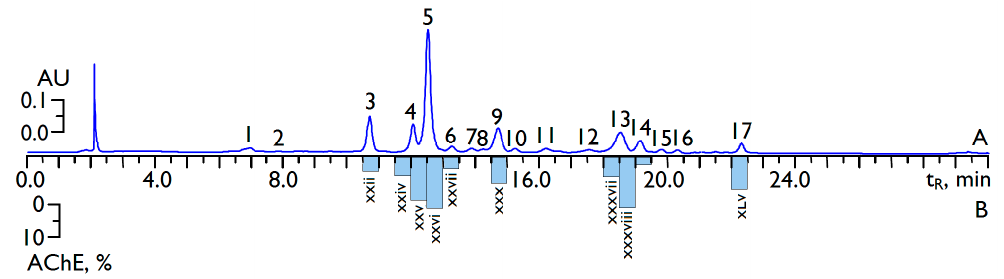
Figure 2. Chromatograms (microcolumn reversed-phase high-performance liquid chromatography with ultraviolet detection (MC-RP-HPLC-UV)) of 60% ethanol extract from C. officinalis of the Greenheart Orange variety at 350 nm (A) and HPLC-based anti-acetylcholinesterase activity (AChE) profiling (B). The bar graphs on B show the inhibitory activity of the individual HPLC fractions collected from a single separation. Compounds: 1, 3- O -caffeoylquinic acid; 2, caffeic acid; 3, manghaslin; 4, calendoflavobioside; 5, typhaneoside; 6, rutin; 7, isoquercitrin; 8, quercetin-3- O - (2”-ramnosyl)-rhamnoside; 9, calendoflavoside; 10, 3,5-di- O -caffeoylquinic acid; 11, quercetin-3- O -